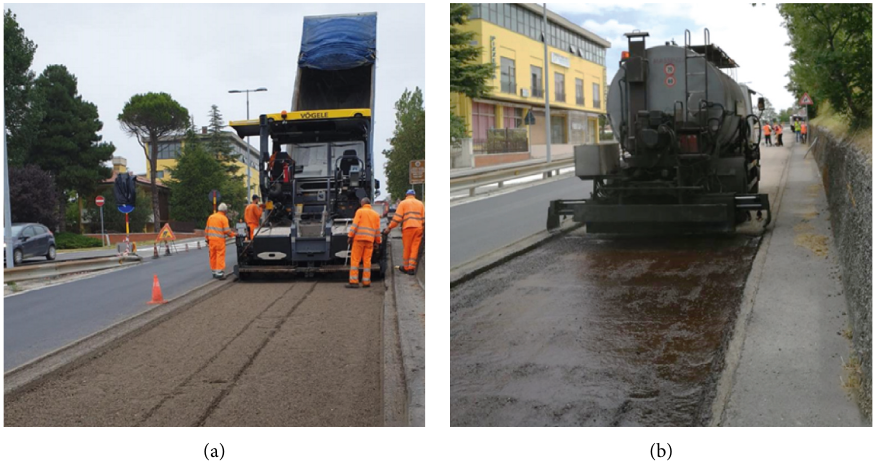
Figure 7: Construction of the new base course for subsection 1: (a) laying of CTRM; (b) application of the prime